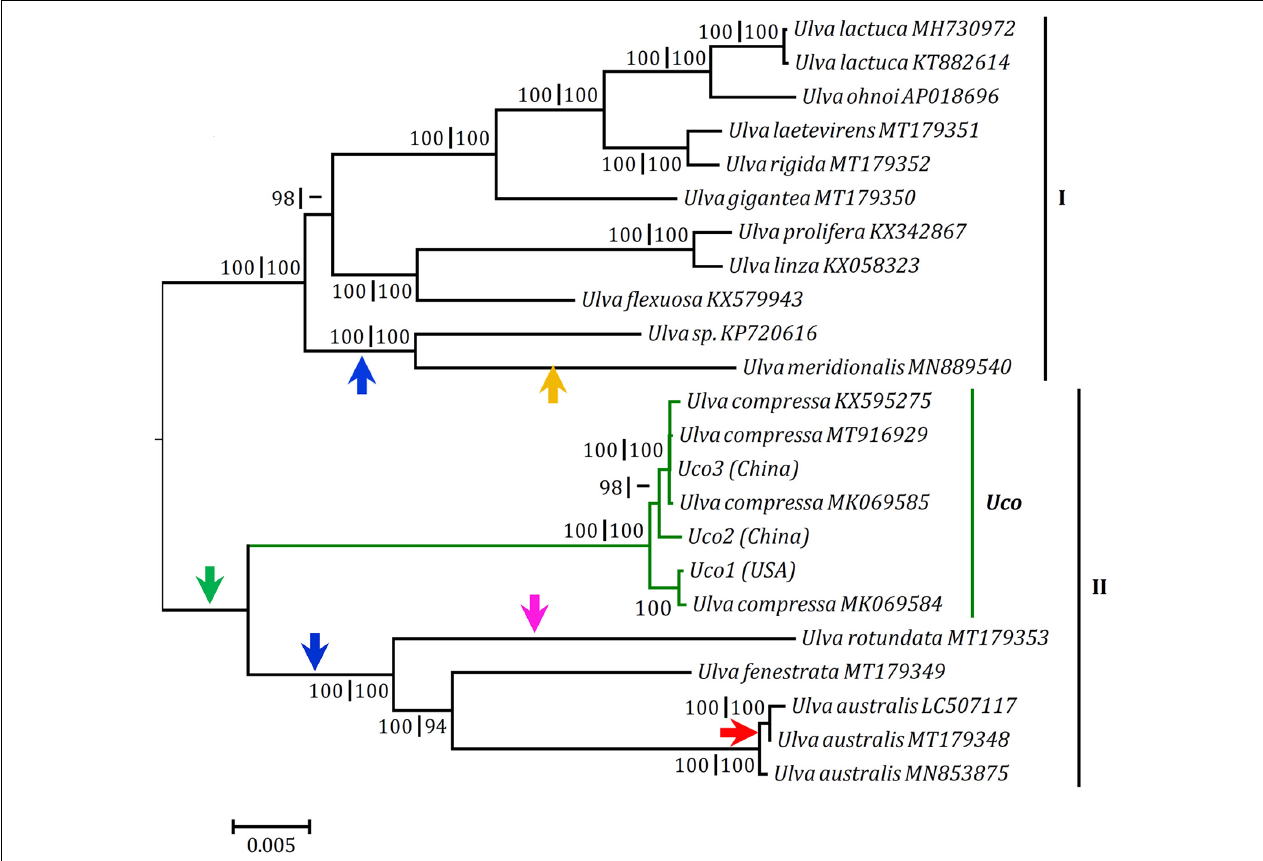
FIGURE 5 | Phylogenomic trees based on Maximum Likelihood (ML) analysis of the nucleotide (nt) sequences of the 100 common genes and the amino acid (aa) sequences of the 71 common PCGs in the 23 Ulva chloroplast genomes. The ML analysis was conducted with 1,000 bootstrap replicates using MEGA 7.0. The bootstrap support values greater than 80% were displayed at branches. Branch lengths were proportional to the amount of sequence change, which were indicated by the scale bar below the trees. Arrows with different colors represented reversal events of different gene blocks: two genes ( psbD - psbC ), green; 45 genes from psbB to trnT(ugu) , blue; nine genes ( psbD - psbC - trnR3 - trnM3 - trnD - psaB - psbM - trnH-trnS2 ), pink; six genes ( trnM3-trnD - psaB - psbM - trnH-trnS2 ), orange; and trnE(uuc) ,